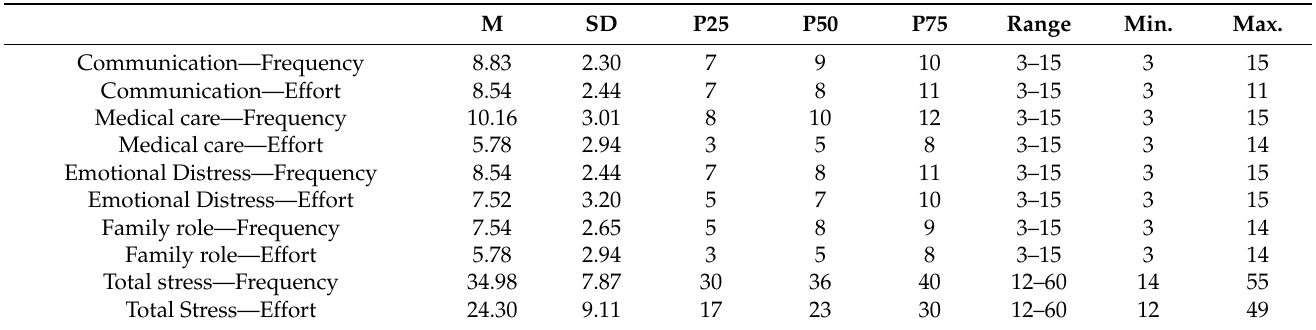
Table 3. Descriptive statistics for Pediatric Inventory of Parents scale values of the primary family caregivers (n =